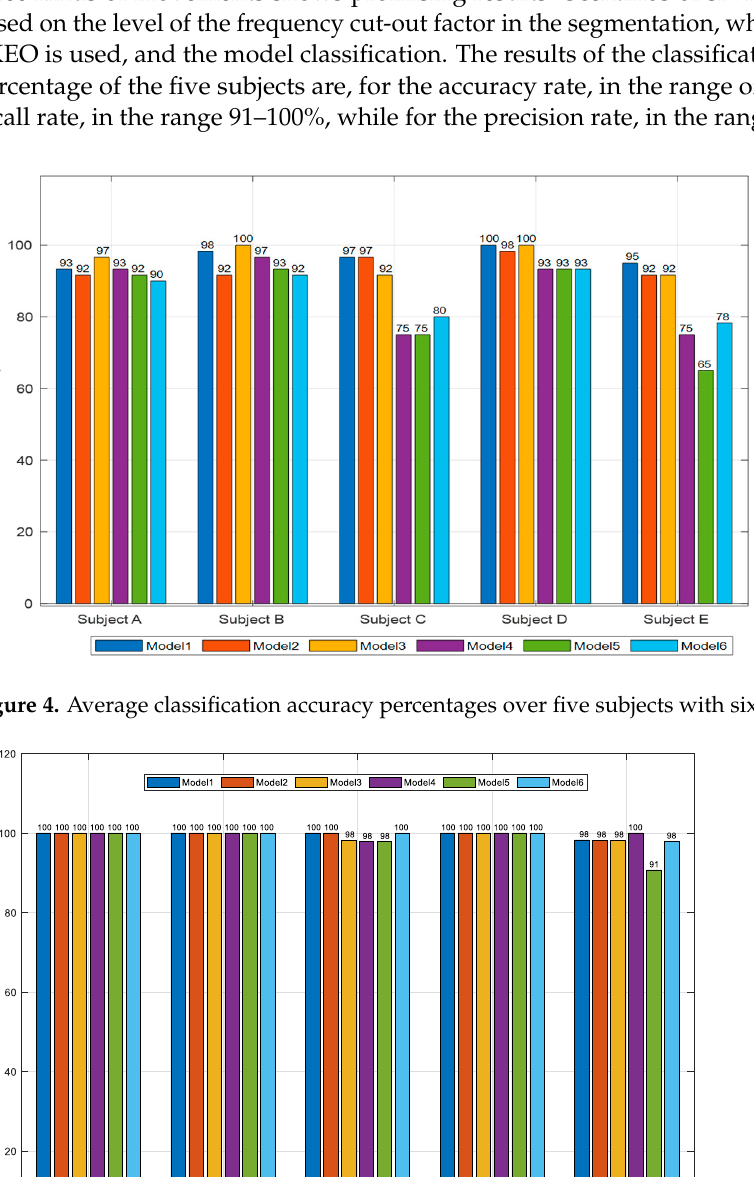
Figure 6. Average precision percentages over five subjects with six models. Subject D reports the highest consistent accuracy results than the others, model 1 achieved the highest average percentages of accuracy at 97.67%, while model 6 obtained the lowest at 86.33 %(see Table 2). At least all the subjects reported consistent results for recall rate, ranging from 96.97% to 99.67%. Subject A had the most consistent precision with model 1 which reported an average precision of 96.99%. The reasons why the perfor- mances are varied are because of motion artifacts and inconsistent motion issues. Table 2. Total performance index. Model